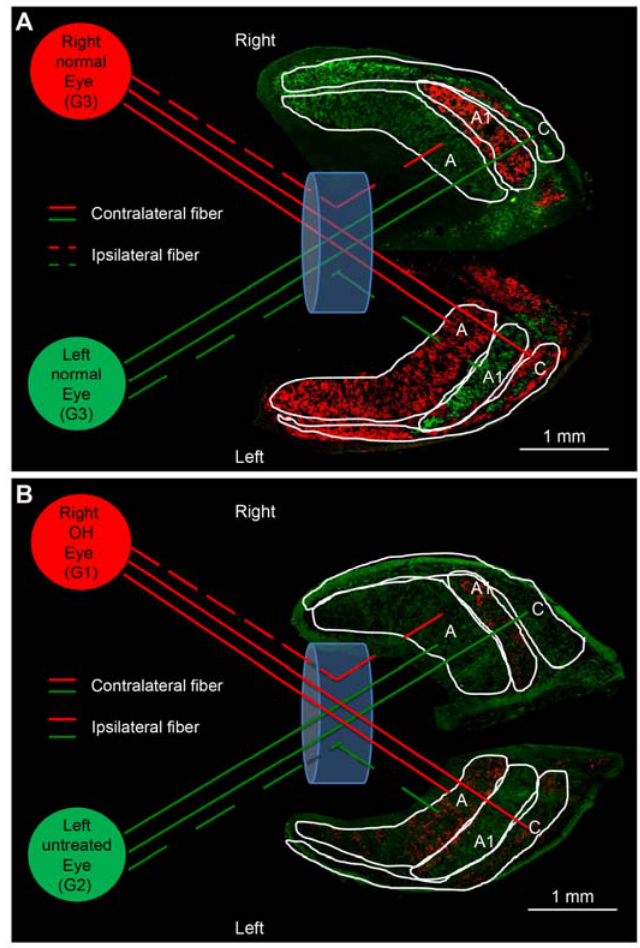
Figure 2. Axonal projection from the eye to lateral geniculate nucleus (LGN) layers in the normal and OH ferret. ( A ): A and C layers project to the contralateral side, whereas A1 layer projects to the ipsilateral side. Red and green CTB injected into the right and left eyes, respectively, are projected on both sides of LGN in control ferrets and looks similar staining intensity (white bar = 1 mm). ( B ): In OH ferrets, left A and C layers and right A1 layers of LGN projecting from the right OH eye (G1) showed weaker CTB staining intensity compared to those from the left untreated contralateral eyes (G2; white bar = 1 mm).